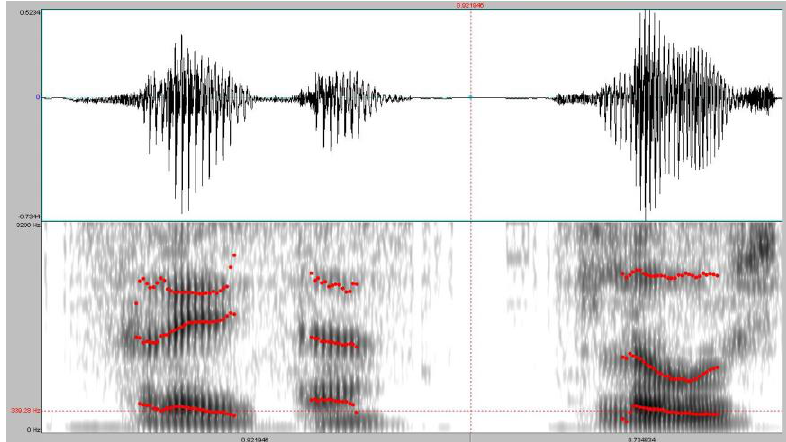
Figure 5: Spectrogram of fruta ‘fruit’ (left) and flores ‘flowers’ (right) as produced by Speaker S. Note the wide spacing of the first and second formants in fruta , indicative of a high front vowel. Note, too, the similarity of F1 in the stressed vowels in both word (approximately 340 Hz), suggesting a high tongue